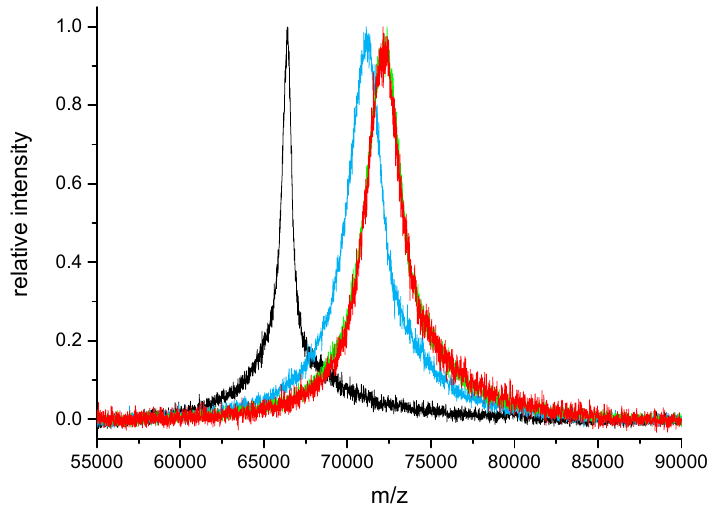
Figure 4. Saturating SIA activation of BSA in several steps (matrix-assisted laser desorption/ionization time-of-flight (MALDI-TOF) mass spectra). A 60-fold excess of SIA, pH 8.3, black: bovine serum